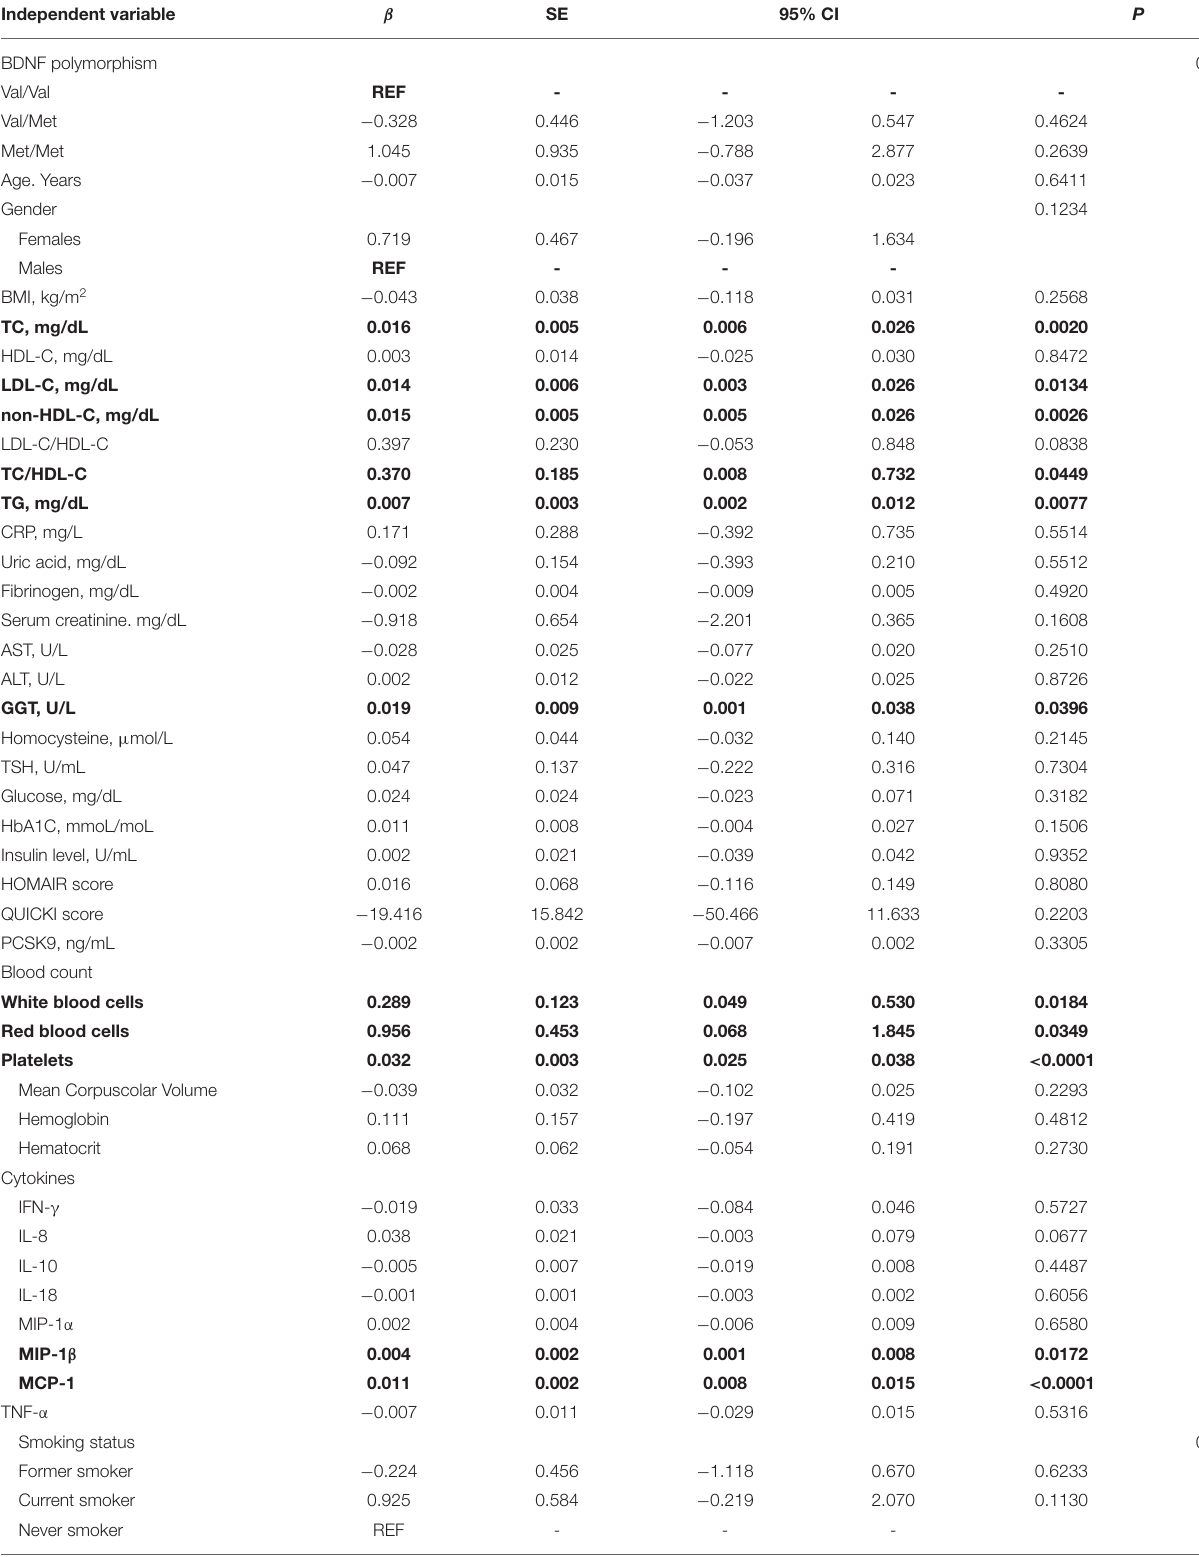
TABLE 3 | Slope coefficients from univariate linear regression models to evaluate association between BDNF and demographics and clinical characteristics of participants. Independent